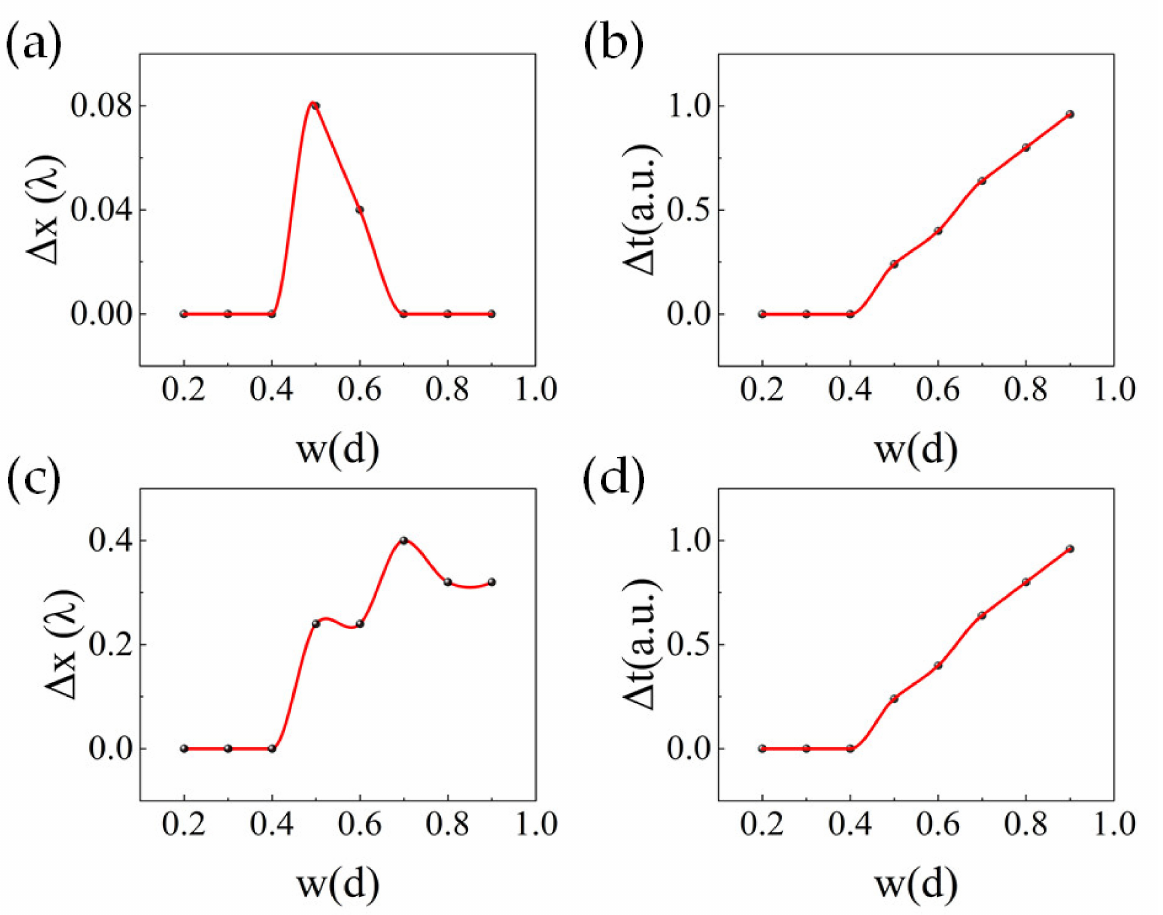
Figure 5. The relationship between the vortex spacing in the transversely polarized components of the focused wave packet and the incident spatial waist radius. ( a ) Vortex spacing of the x-polarized component along the x-axis in the focal region. ( b ) Vortex spacing of the x-polarized component along the t-axis in the focal region. ( c ) Vortex spacing of the y-polarized component along the x-axis in the focal region. ( d ) Vortex spacing of the y-polarized component along the t-axis in the focal region. The d in the horizontal axis in each subfigure represents the pupil radius of the high NA